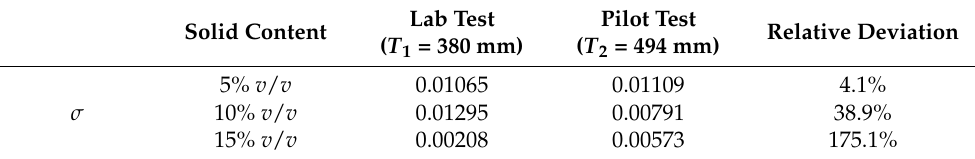
Table 8. The solid uniformity σ before and after scaling up based on the same Weber number.